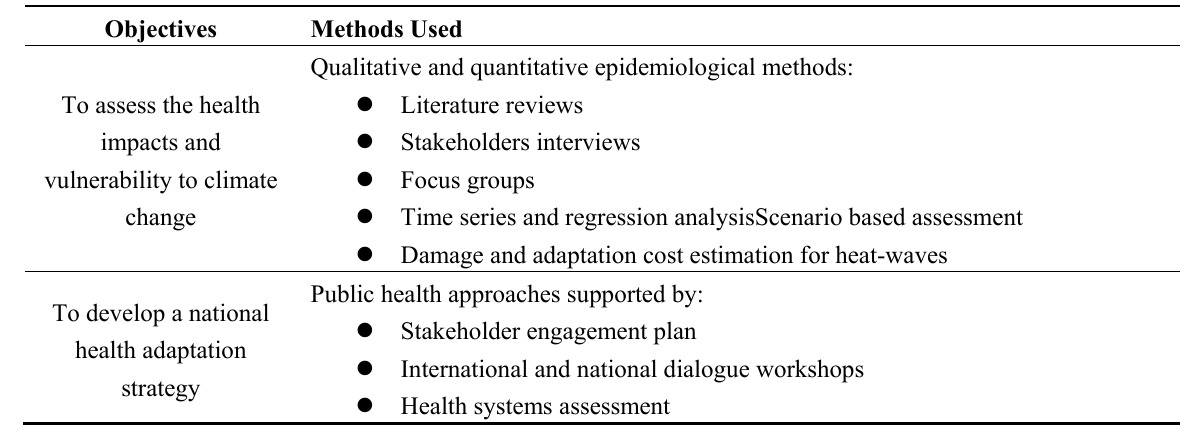
Table 1. Specific objectives and